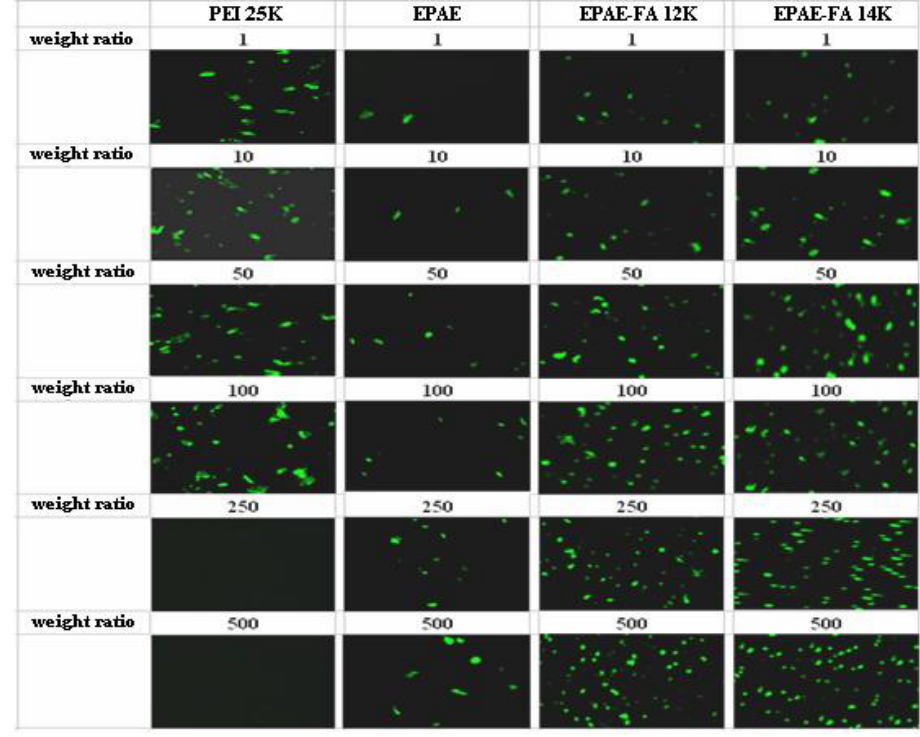
Figure 9. Fluorescence images of GFP expression in HeLa cells transfected using PEI25k, EPAE, EPAE-FA12k, and EPAE-FA14k at various weight ratios.